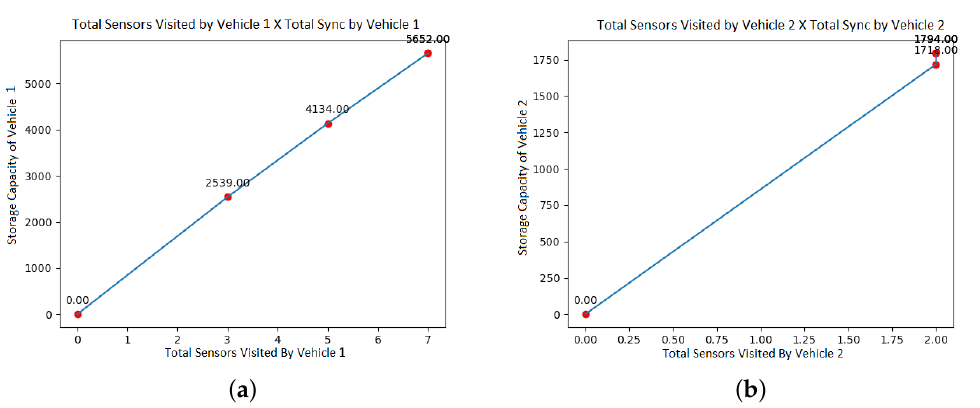
Figure 4. Total sensors visited versus total sync. ( a ) Total sensors visited by Vehicle 1. ( b ) Total sensors visited by Vehicle